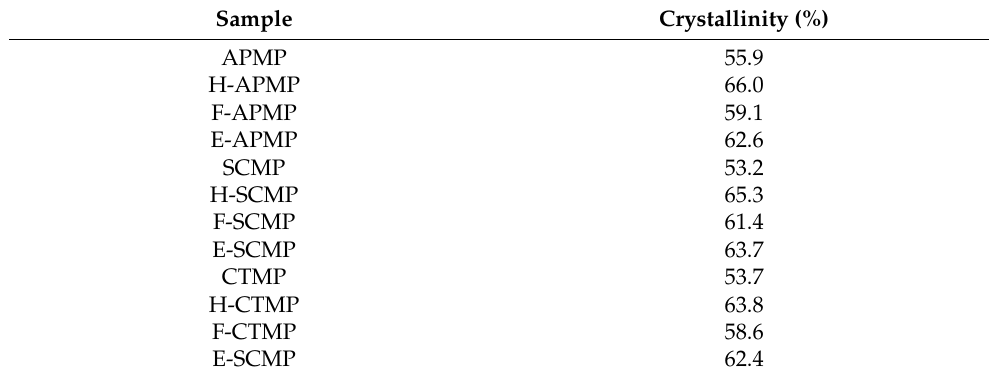
Figure 2. XRD analysis of the samples: ( a ) APMP samples, ( b ) SCMP samples, and ( c ) CTMP samples. Table 2. Crystallinity of the